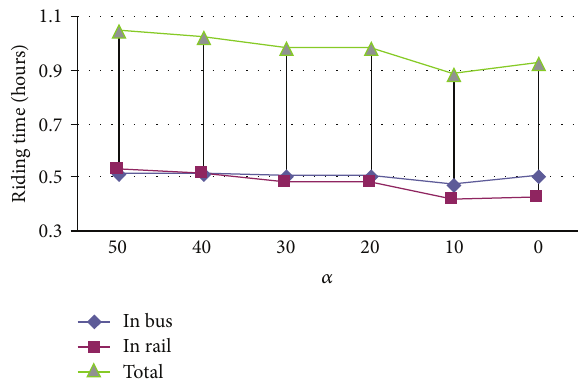
Figure 6: Effect of demand distribution on passengers’ travel time.